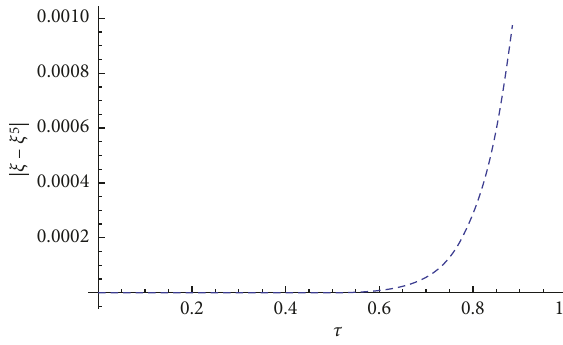
Figure 6: The absolute errors of Example